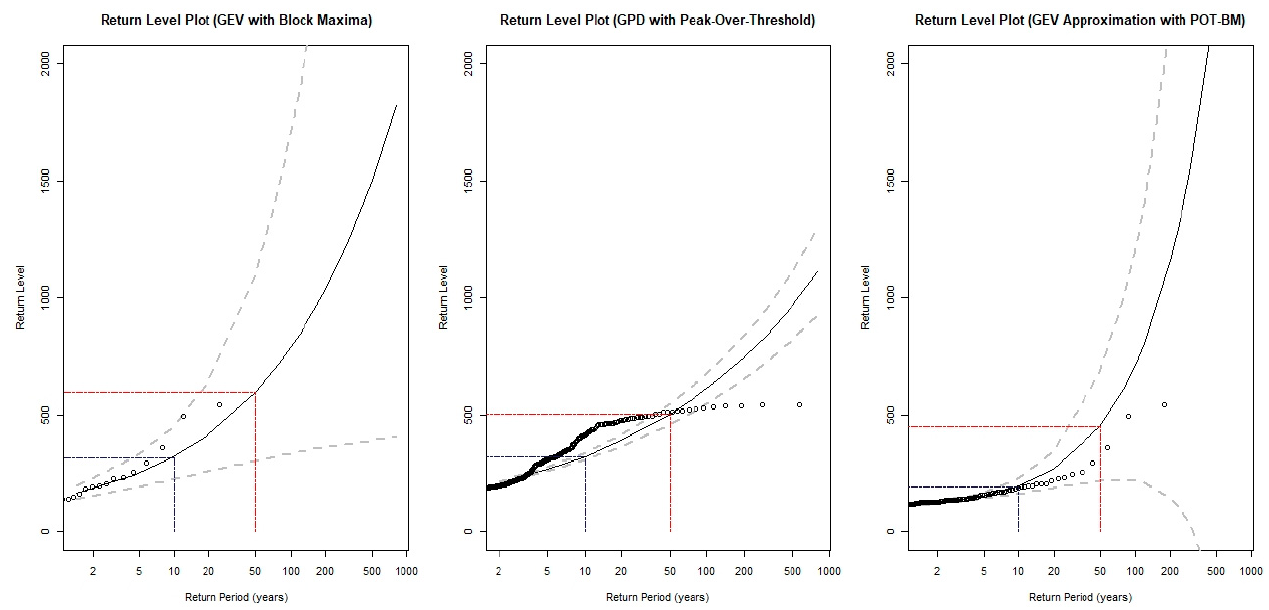
Figure 8. Comparison of return level plot of fitted models.